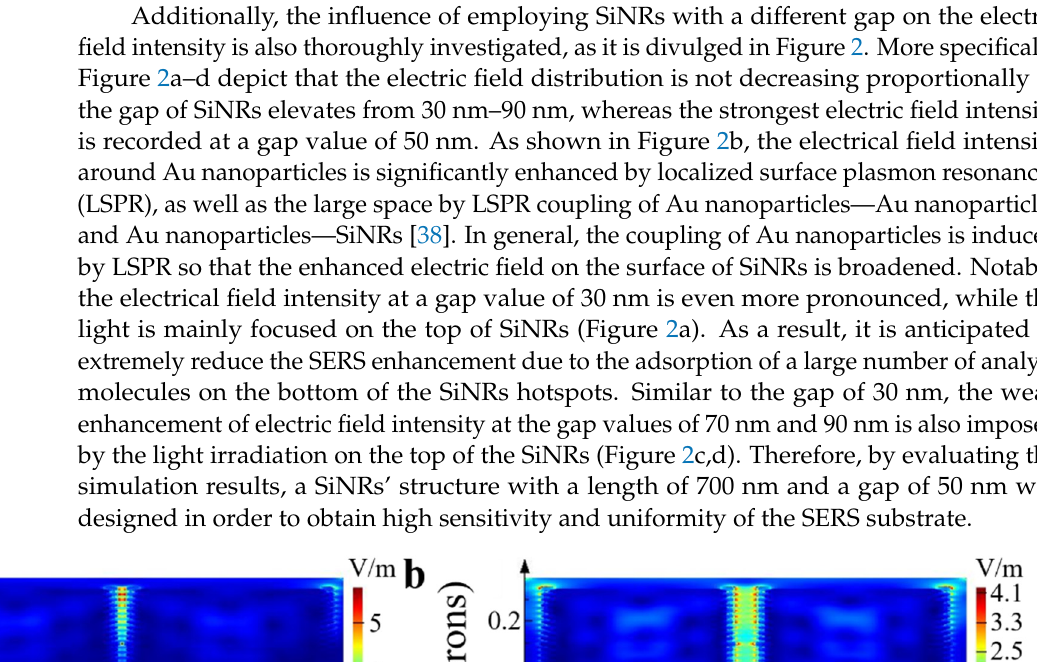
Figure 1. Distribution of the FDTD − simulated near − field electrical intensity in the wavelength of 785 nm with different SiNRs’ length. ( a ) 500 nm, ( b ) 700 nm, ( c ) 900 nm and ( d ) 1100 nm.